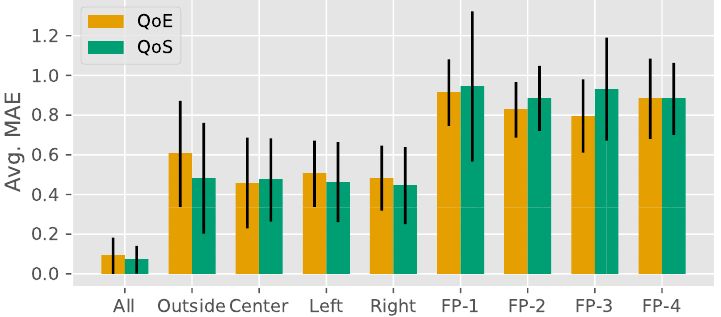
Figure 6. Mean Absolute Errors (MAE) for the spherical image (SAR) condition averages and standard deviations for subject ratings (QoE) and impairment level (QoS) prediction performance analysis of individual subjects.